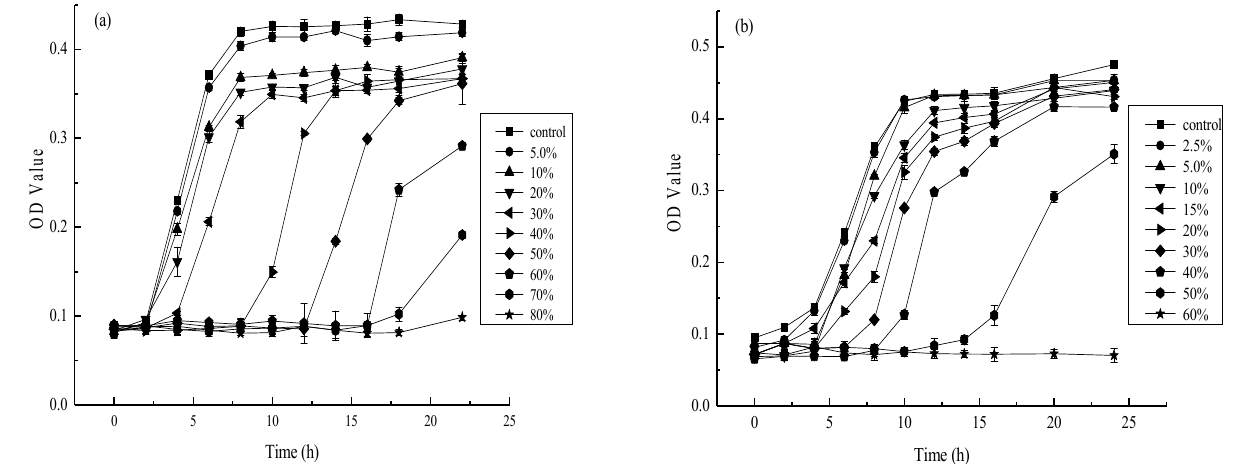
Figure 4. Antibacterial activity of microorganism under different concentrations of nano-silver colloid (( a ) E. coli , ( b ) S. aureus